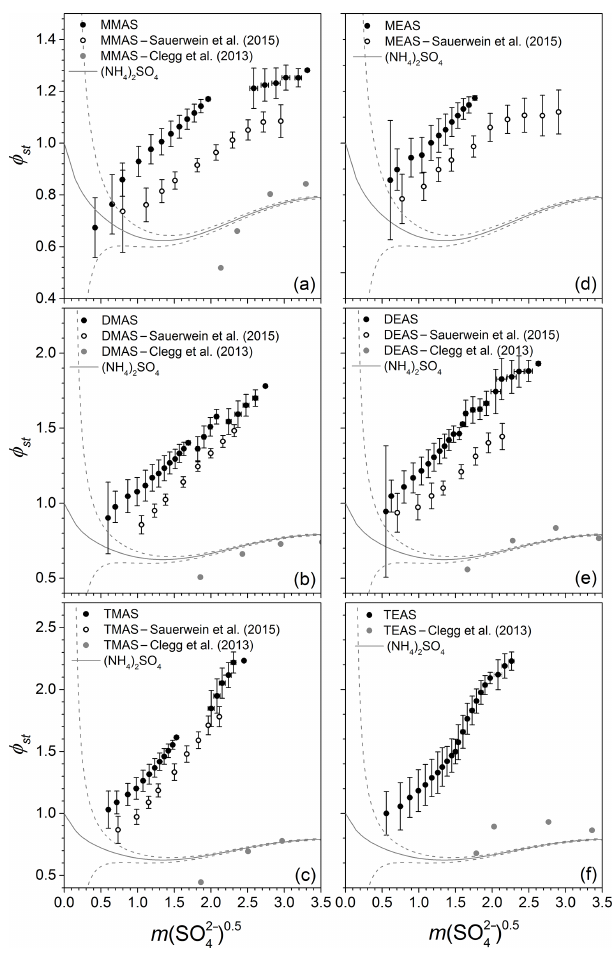
Figure 6. Osmotic coefficients ( φ st ) vs. square root of sulfate mass ) 0 . 5 ) for the six aminium sulfates. Symbols: black fraction ( m (SO 2 − 4 circles – CK-EDB comparative kinetics measurements; open cir- cles – Sauerwein et al. (2015); grey circles – Clegg et al. (2013) (based on measurements from Qiu and Zhang, 2012); solid line – (NH 4 ) 2 SO 4 calculation from E-AIM model; dashed lines – uncer- tainty of the osmotic coefficients for (NH 4 ) 2 SO 4 corresponding to an error in a w of ± 0.002, included to provide a guide as to the level of expected error in the osmotic coefficient with varying molality.